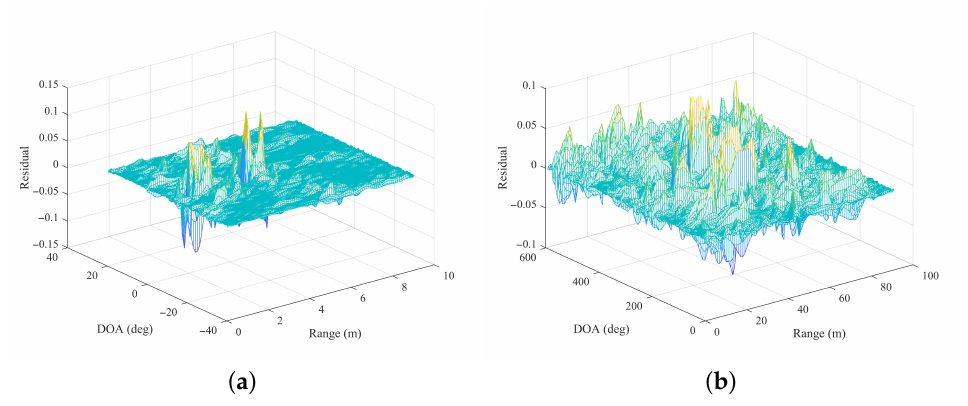
Figure 16. Residuals of low-resolution: ( a ) Single target. ( b ) Two targets. Figure 17a,b shows the high-resolution images of the single and double-target exper- imental data, respectively, which complement the details of the low-resolution images. As can be seen from the figures, the image peaks are not very sharp, which indicates that with the decrease of the distance between targets, the grid needs to be further refined to achieve better results also.